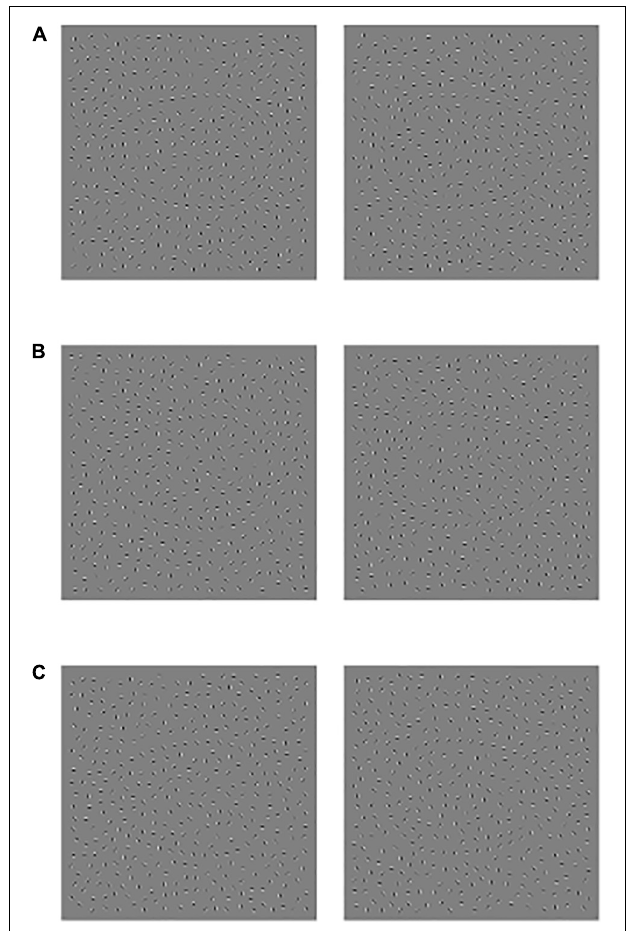
FIGURE 1 | Schematic diagram of experimental material, (A) Jitter30, (B) Jitter60, and (C) Jitter90, the profile orientation of the left side figure is left, and the profile orientation of the right-side figure is